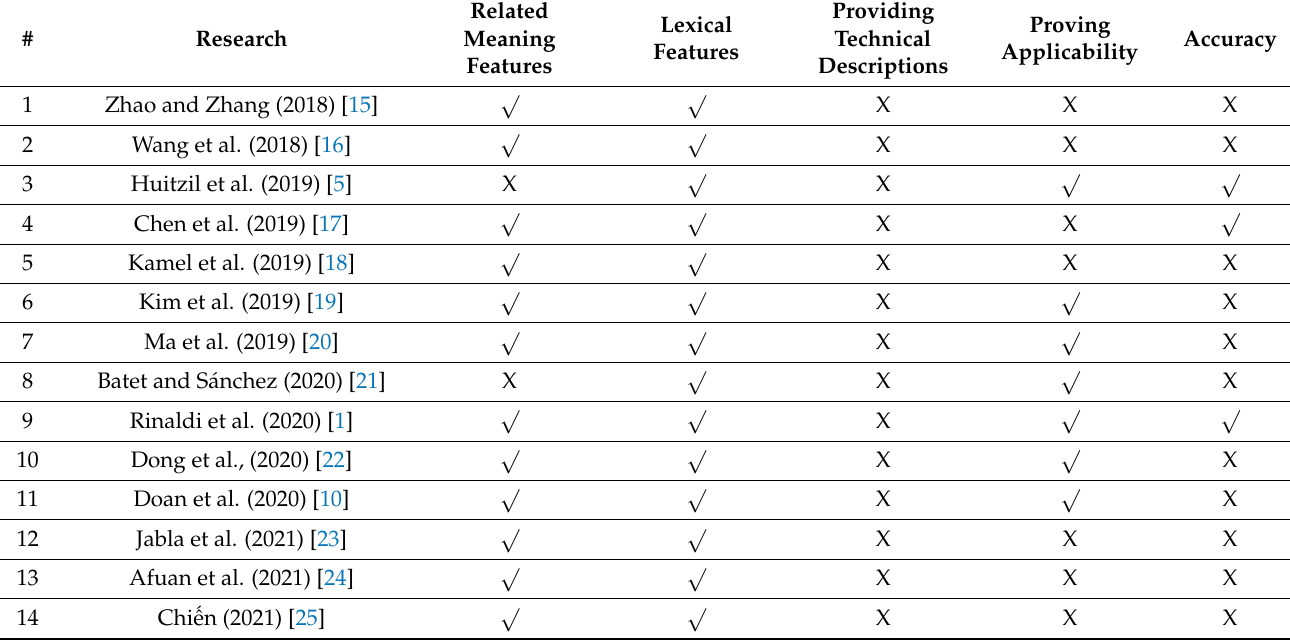
Table 12. The results of the benchmark